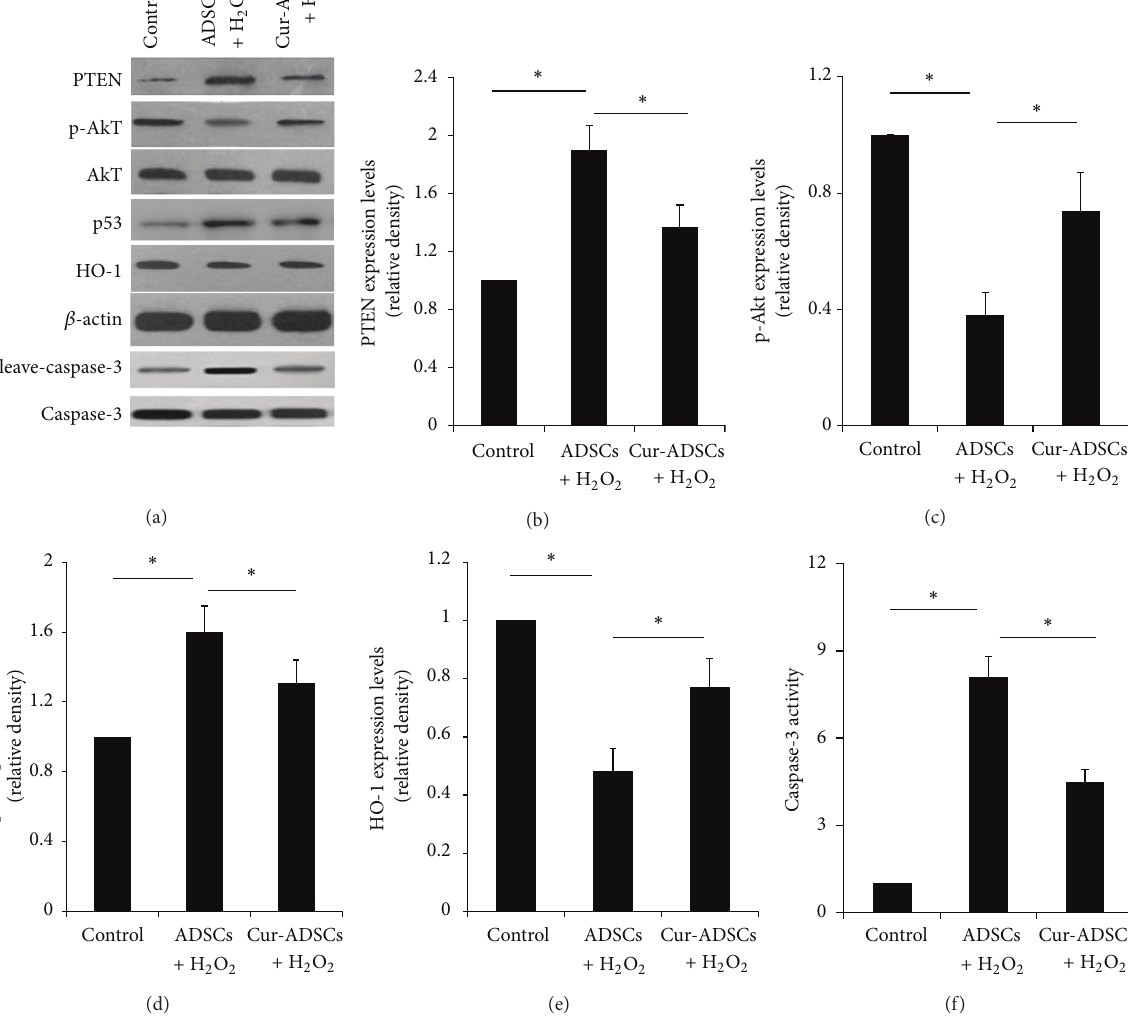
Figure 2: Effects of curcumin pretreatment on PTEN/Akt/p53 and HO-1 signaling proteins expression. (a) Representative Western blots of PTEN, p-Akt, Akt, p53, HO-1, cleave-caspase-3, caspase-3, and 𝛽 -actin. ((b)–(f)) Quantitative analysis of PTEN, p-Akt, Akt, p53, HO-1, and cleave-caspase-3. The results showed that curcumin pretreatment significantly increased the expression of p-Akt and HO-1 and reduced the PTEN, p53, and cleave-caspase-3 expression ( 𝑃 < 0.05 ). ∗ 𝑃 < 0.05